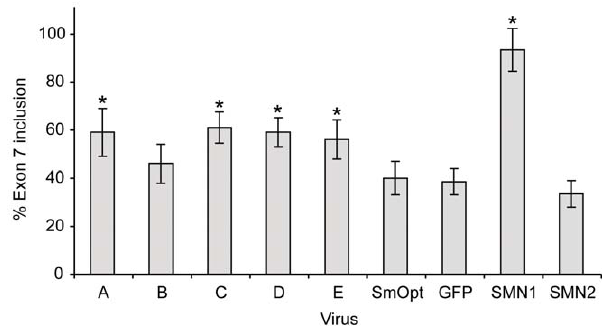
Figure 2. Effect of antisense U7 snRNAs delivered by Adv-5 vectors on SMN2 minigenes. HeLa cells were transiently transfected with either SMN2 or SMN1 minigenes spanning exons 6 through 8. 12 hours post transfection tissue cultures were transduced with Adv-5/ antisense U7 snRNAs or control vectors (SmOpt, GFP) at a MOI of 20. The bar summarizes exon 7 inclusion levels observed from 7 independent experiments. Standard deviations are shown for each series. An asterisk above bars indicates a statistically significant difference between the experimental series and the SmOpt control series. A statistically significant difference between series is defined by p-values , 0.005.